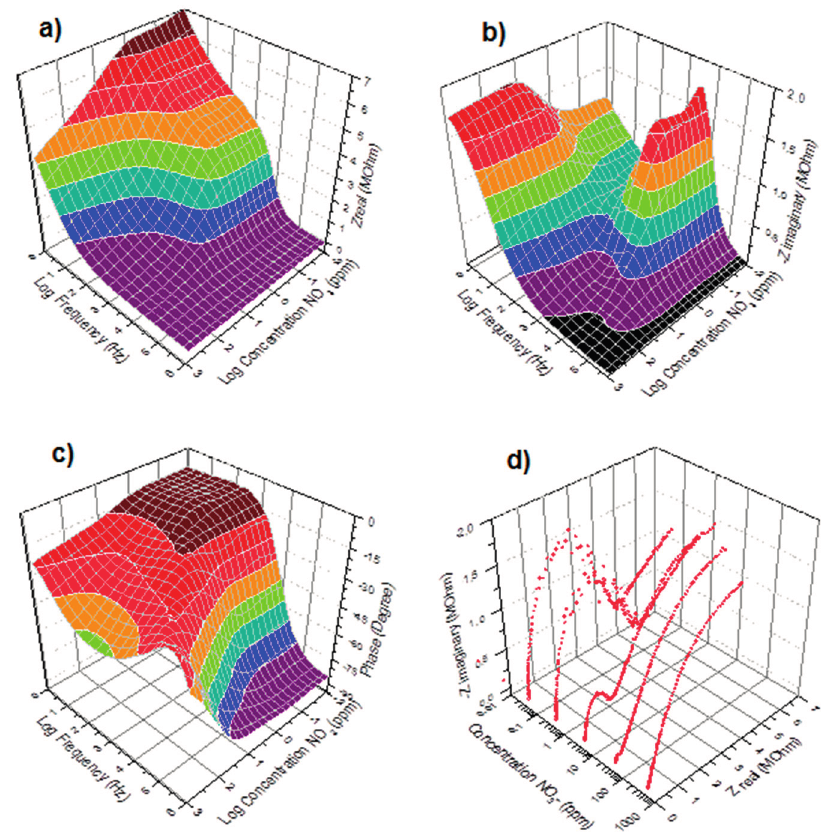
Figure 2. Real ( a ), Imaginary ( b ), Phase ( c ), and Nyquist ( d ) impedance spectra of the immersed PVC-BEHP electrochemical nitrate sensors, at 200 mV AC amplitude, through a wide range of nitrate (NO 3 − ) concentrations using KNO 3 -containing water